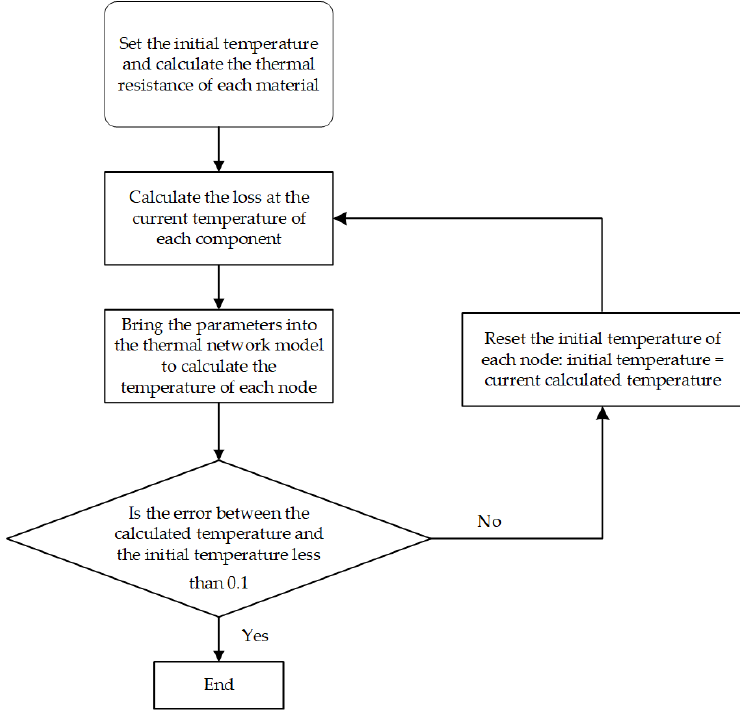
Figure 9. DHEG thermal network model calculation flow.